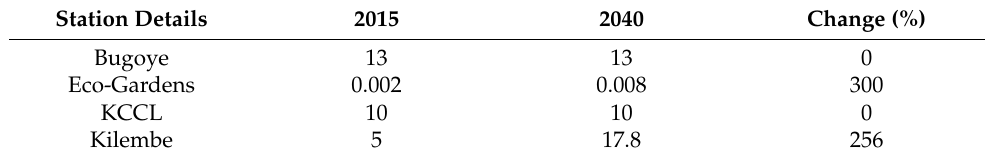
Table 7. 2015 and 2040 Hydropower water demand (MW) in Mubuku sub catchment.